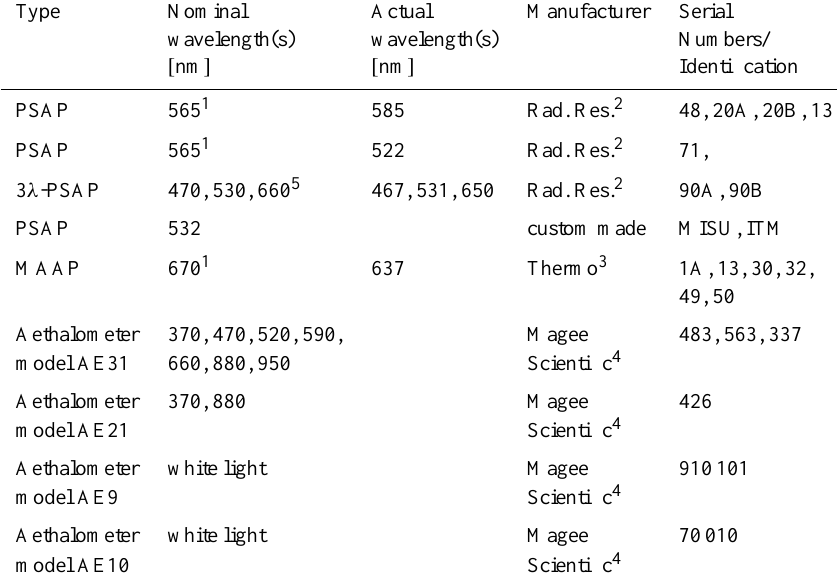
Table 4. Absorption photometers at the GAW2005